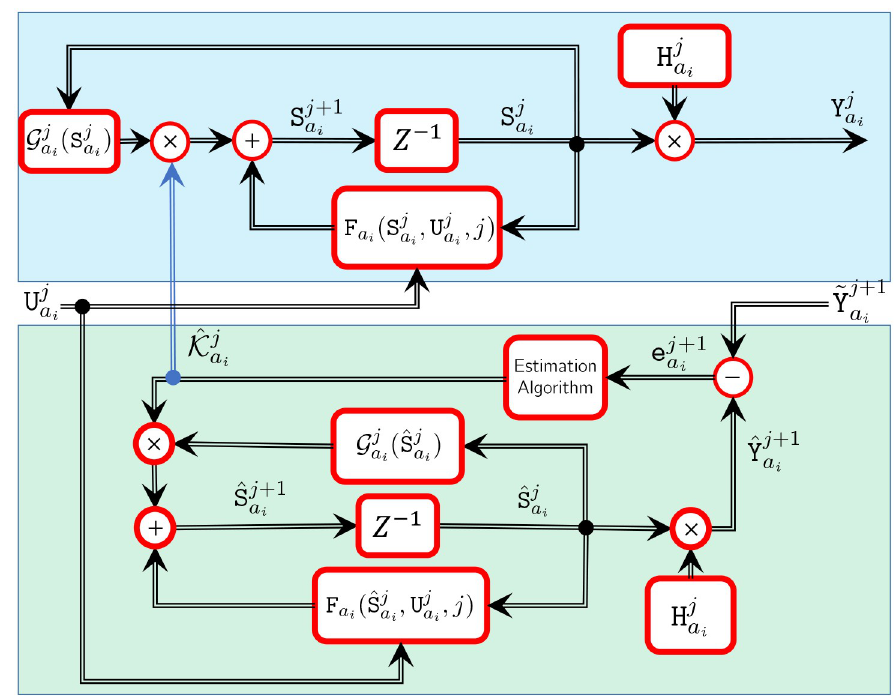
Fig 4. Block diagram of the proposed prediction filter a model’s output to perform a pointwise optimization problem to predict the damping capacity ^ K i